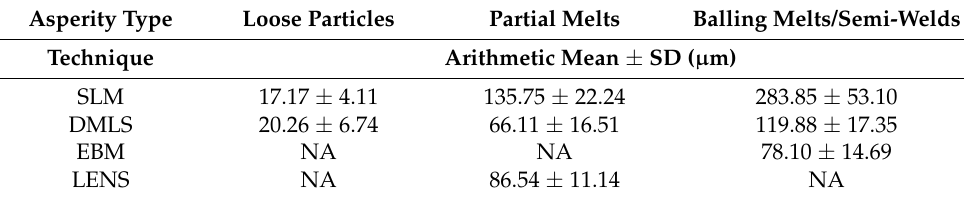
Table 2. Maximum diameter of asperities in AM surface.